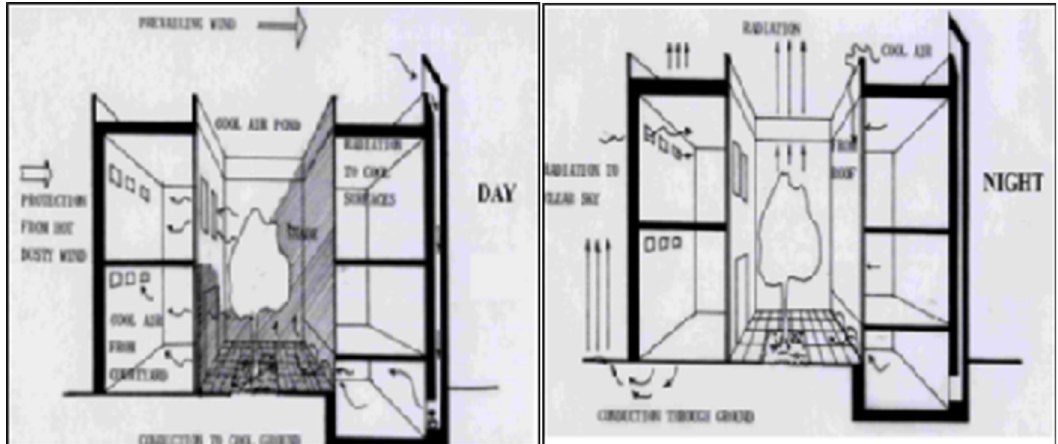
Fig. 6. Diagram of the thermal system for courtyard buildings. Drawing by the author. Source: Mosul: The Architectural Conservation in Mosul Old Town (cid:1) Iraq, 2010; page 35. Author noticed that the traditional Bahraini house layout was affected by Baghdadian house layouts, however, few houses in Bahrain towns contain Badgeer out of which the underground and wind towers are preferred.